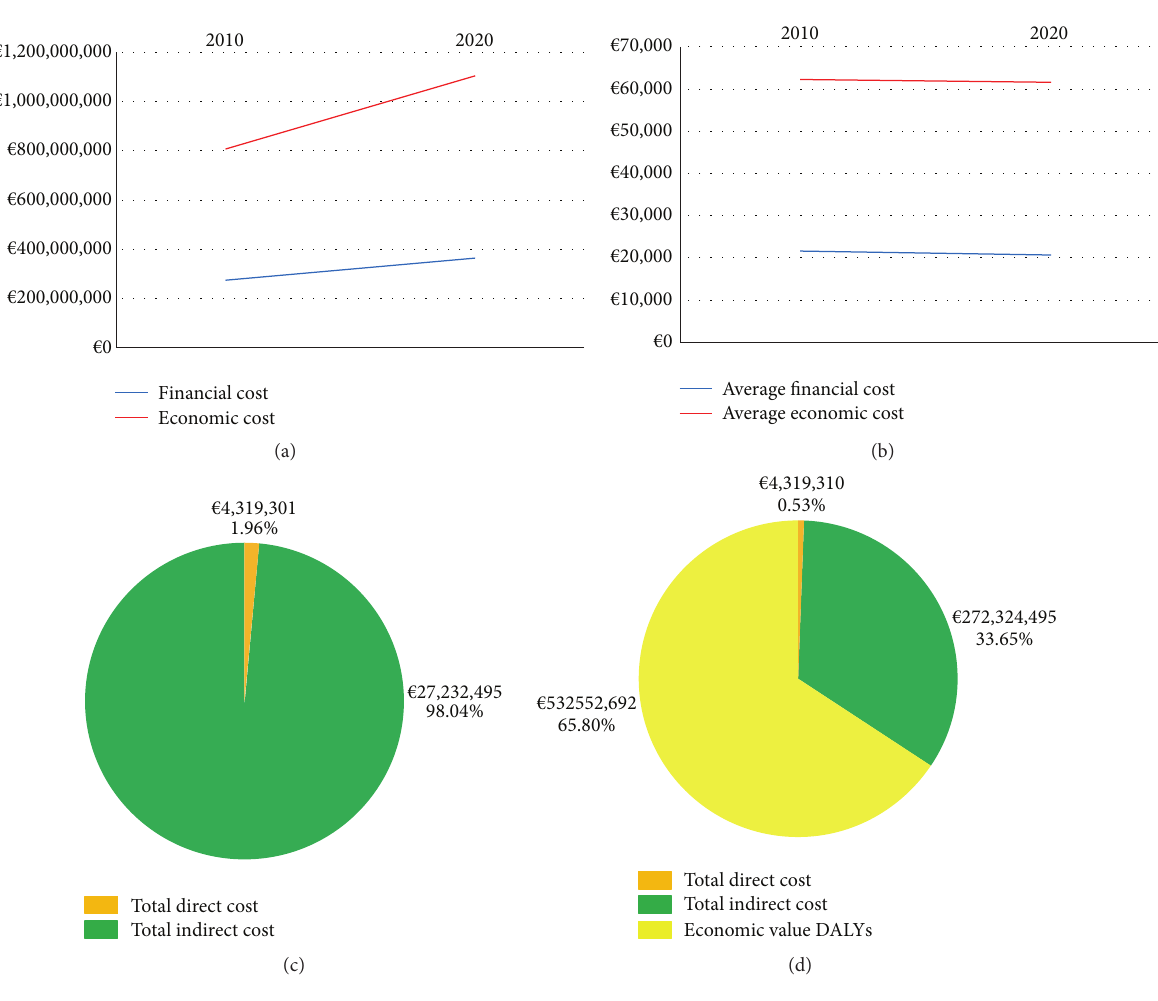
Figure 1: (a) The projected differential increase in the total financial and economic costs of blindness in the Republic of Ireland 2010–2020. (b) The projected differential increase in the average financial and economic costs of blindness in the Republic of Ireland 2010–2020. (c) The financial cost of blindness in the Republic of Ireland. Nonhealthcare costs account for 98.44% of the total financial cost of blindness. (d) The economic cost of blindness in the Republic of Ireland. The cost of disease burden accounts for 65.81% of the annual economic cost of